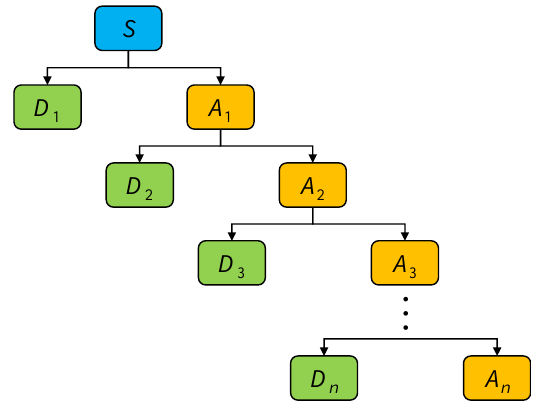
Figure 28. Wavelet decomposition.